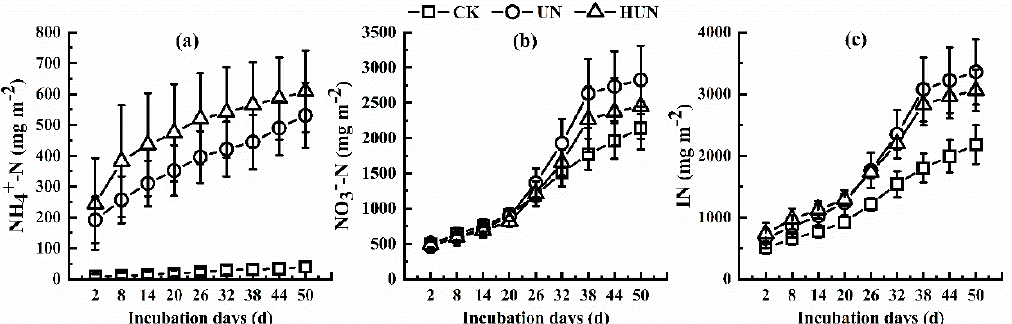
Figure 2. Effects of different treatments on cumulative leaching loss of NH 4+ -N ( a ), NO 3 − -N ( b ) and IN ( c ). The vertical coordinate corresponding to the point is the average value. The length of the error bars is the standard deviation. NH 4+ -N: ammonium nitrogen. NO 3 − -N: nitrate nitrogen. IN: